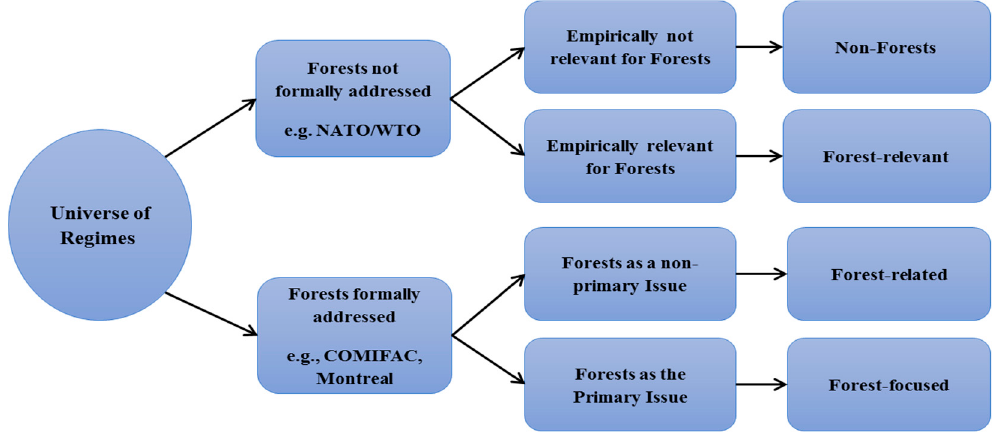
Figure 2. Types of forest regimes based on their empirical issue-focus adapted from [52].